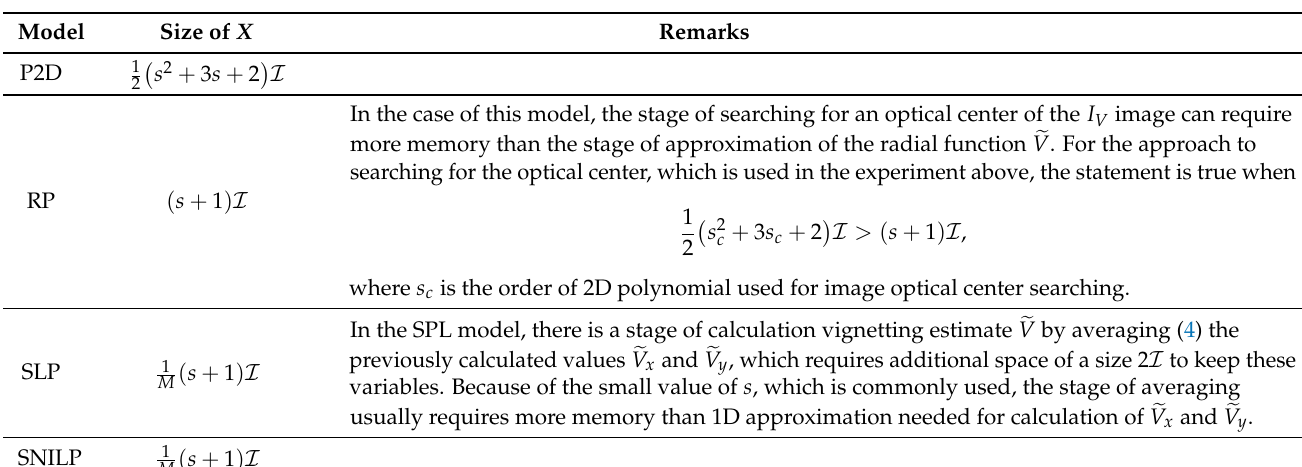
Table 6. Comparison of models required memory